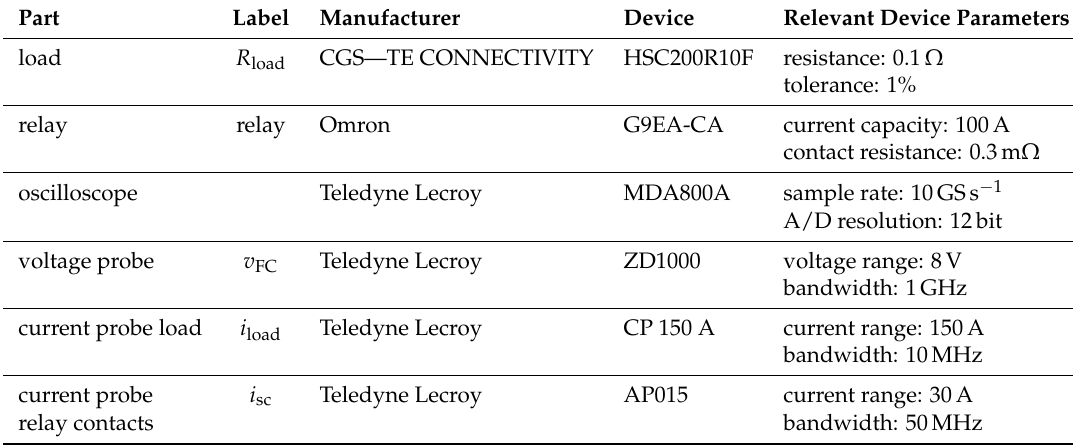
Table 2. Parts of the test